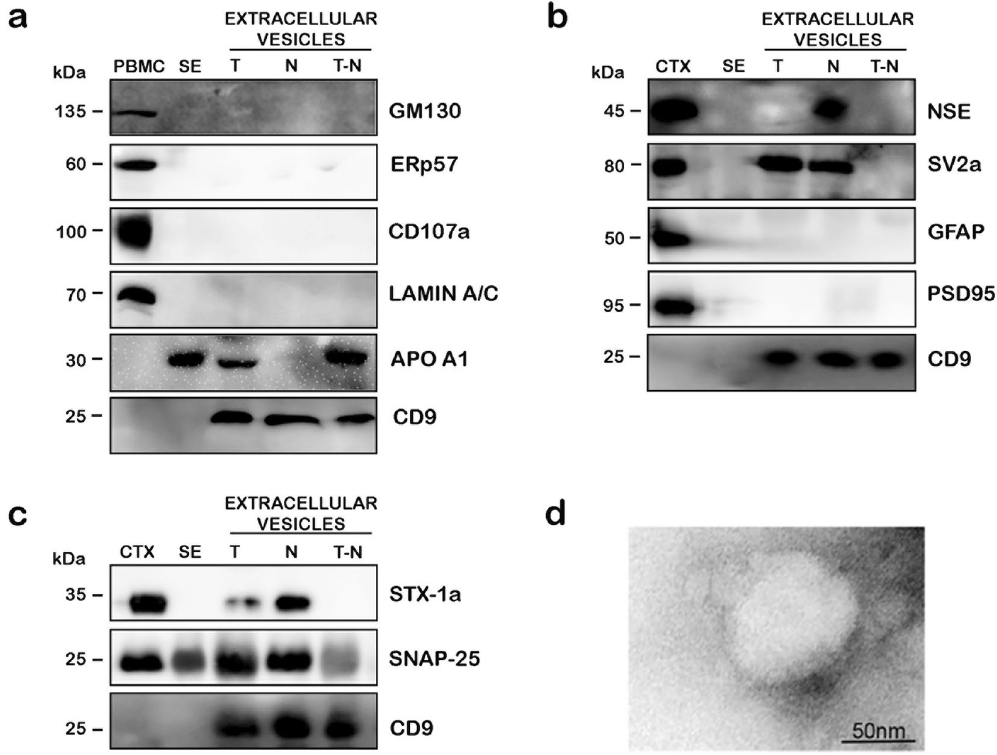
Figure 3. WB analysis of a representative NDE purification from the serum of healthy donors. ( a ) Quality analysis of extracellular vesicle preparation. Extracellular vesicles samples are not contaminated by Golgi apparatus (GM130), endoplasmic reticulum (Erp57), lysosomes (CD107) and nucleus (lamin A/C). The presence of the HDL marker APO A1 is detectable in both total extracellular vesicles (T) and total extracellular vesicles depleted to NDE (T-N), but disappear in NDEs fractions (N). CD9 is a common exosome marker. ( b ) NDE characterization. WB analysis show an enrichment of neuronal markers (NSE and SV-2a) in NDEs with respect to the other two extracellular vesicles fractions. Moreover, NDE samples are negative to the astrocytes and the post synaptic markers GFAP and PSD95, respectively. ( c) STX-1a and SNAP-25 are enriched in NDE fractions. The levels of both SNARE proteins are increased in NDE with respect to the two other extracellular vesicles fractions. ( d ) Representative EM analysis of NDE. The ultrastructural analysis of NDE shows the presence of rounded-shaped vesicles with a diameter range of 70–100 nm. Bars correspond to 50 nm. For WB analysis 100 µg of whole PBMCs, 50 µg of serum (SE), extracellular vesicles fractions (T, N, T-N) and 0.5 µg